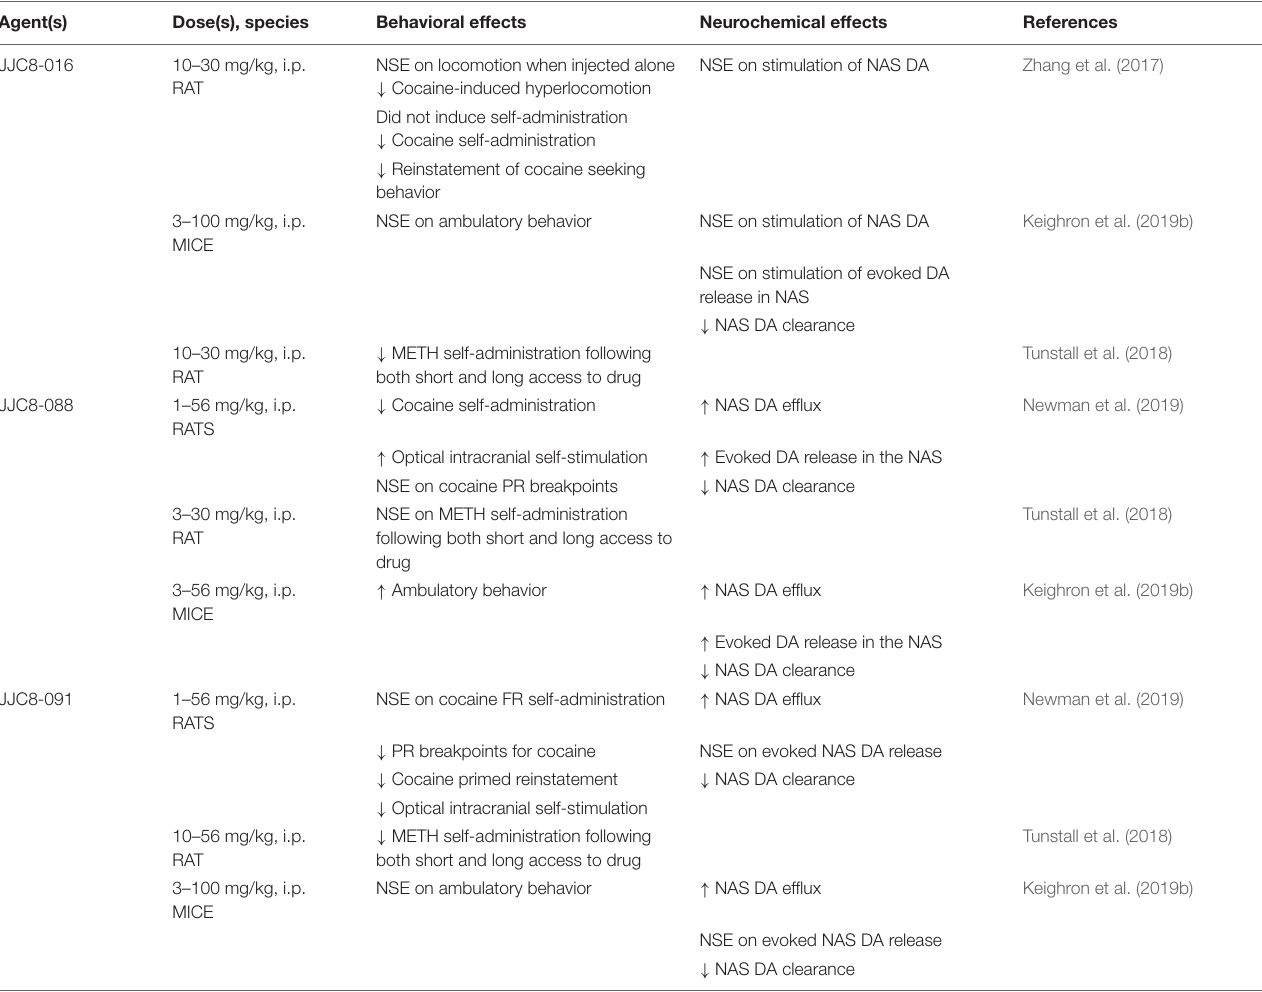
TABLE 5 | Behavioral and neurochemical effects of MOD